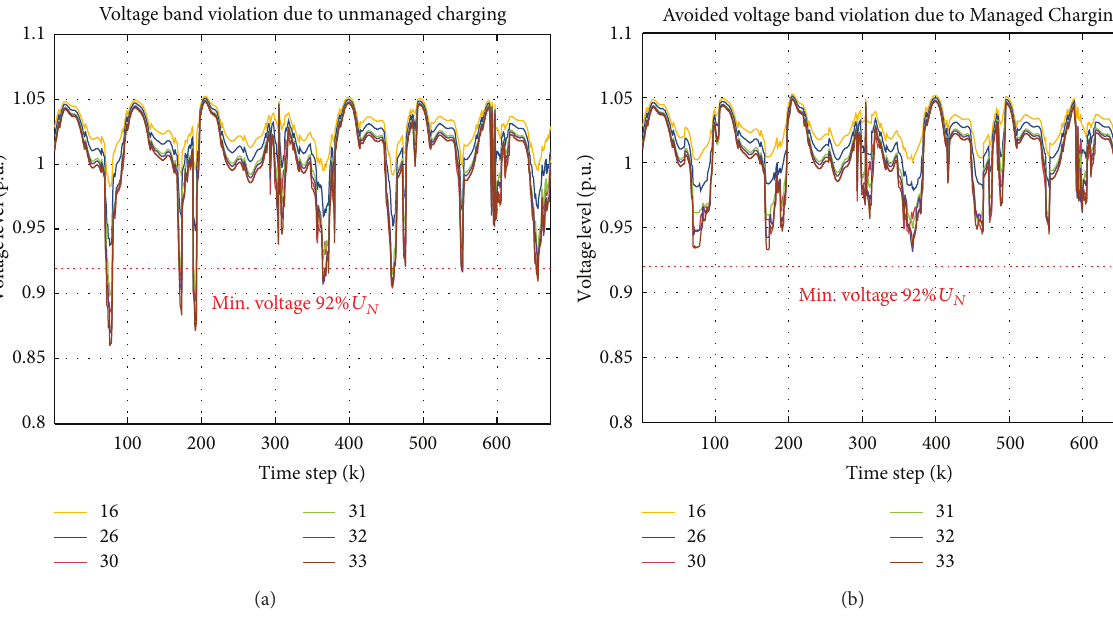
Figure 11: Charging scenario (violation of the voltage